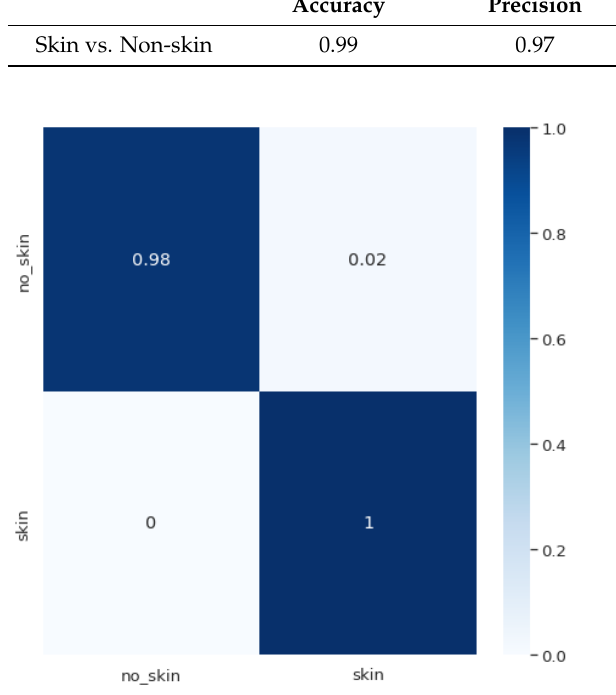
Figure 16. Normalized confusion matrix for skin classification